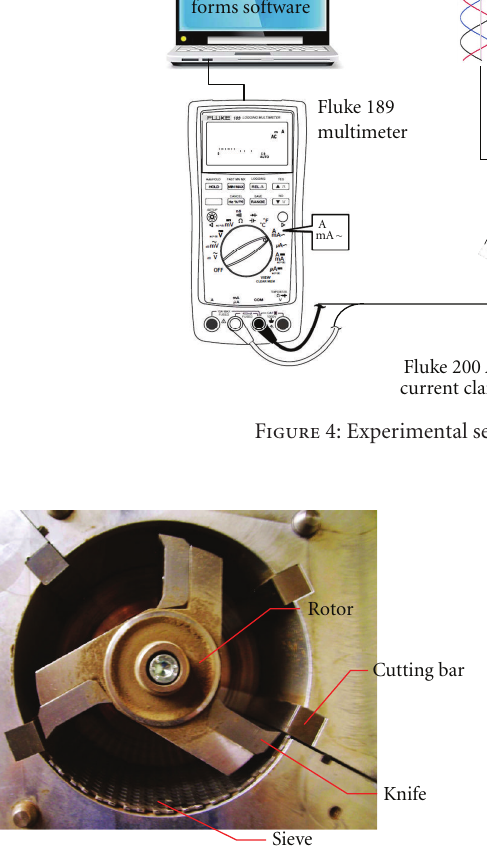
Figure 5: Milling chamber of the knife mill.